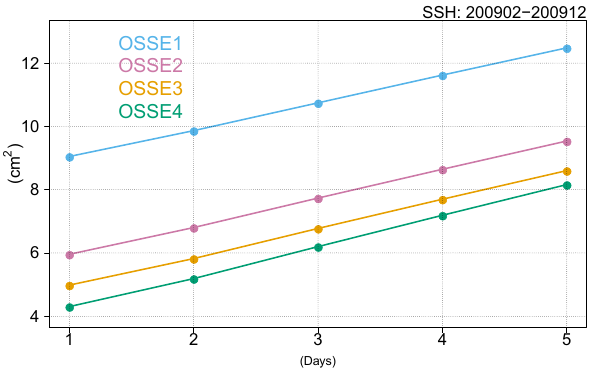
Figure 5. Variance of the error for each day of forecast (5 days) con- sidering the SSH, in regions with a bathymetry deeper than 200m, over the period from February to December 2009. The legend for the OSSEs is as in Fig.